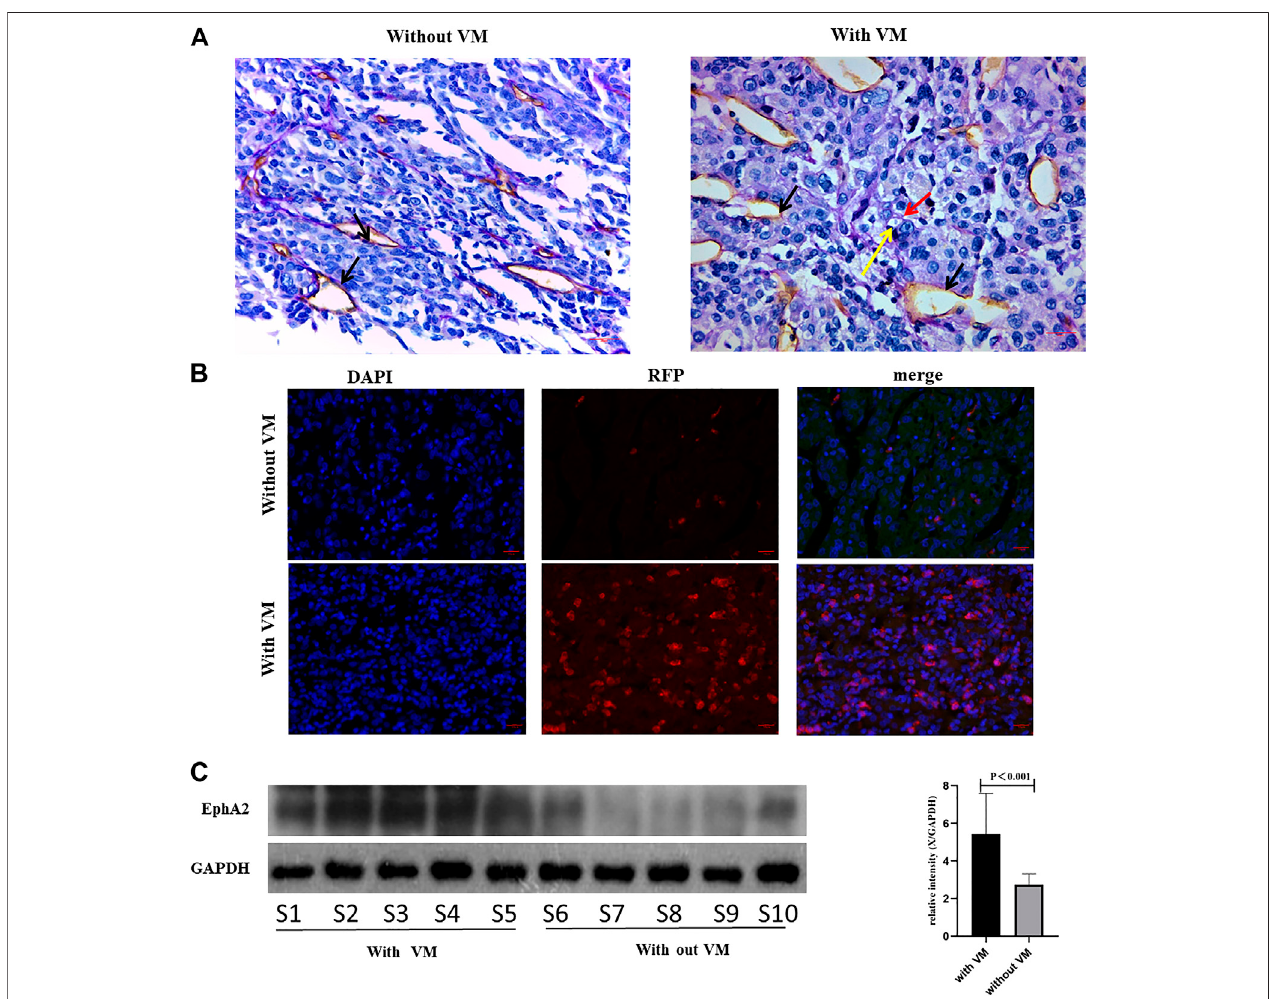
FIGURE 5 | Analyzing EphA2 expression in HCC resection samples. (A) , CD31-PAS staining in HCC samples, red arrow indicates VM, black arrow indicates endothelialdependentvessel,yellowarrowindicatesredbloodcells. × 400,scalebar,50 µm. (B) ,IFforEphA2expressioninresectionsamples.DAPI,4 ’ ,6-diamidino-2- phenylindole, RFP, red fl uorescent protein. × 400, scale bar, 50 µm. (C) , Western blot analysis on EphA2 in 10 HCC resection samples. S1 represents sample 1. Right: relative density derived from Image J process. GAPDH as the internal reference. Two tailed t -test.